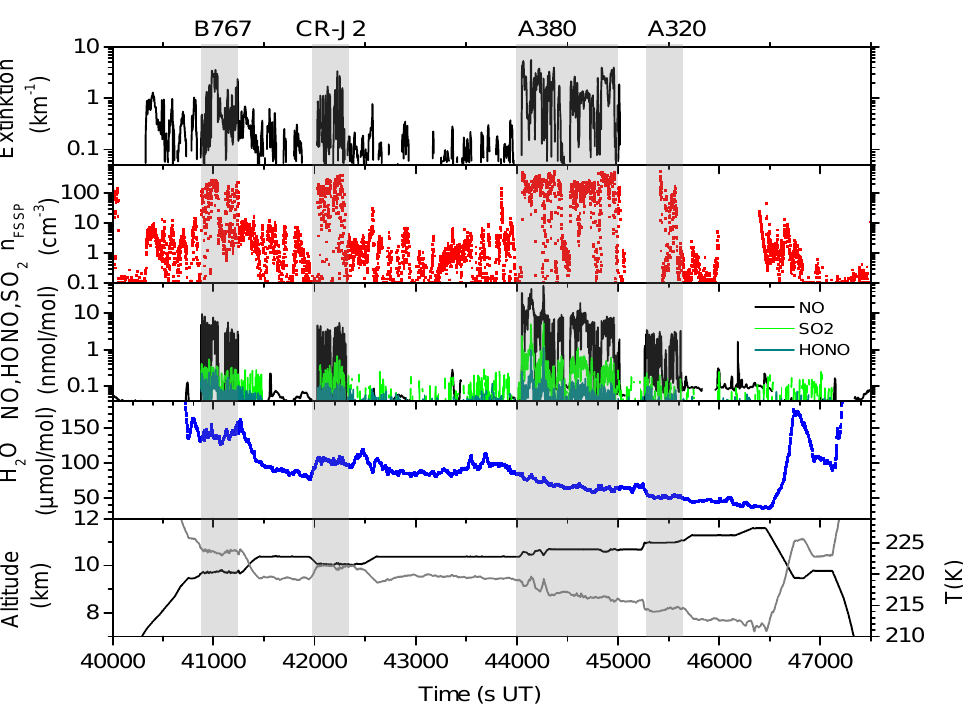
Fig. 6. Contrail flight B on 19 November 2008 above Germany from Hamburg to Oberpfaffenhofen. The flight altitude, temperature, and the H 2 O, NO, SO 2 and HONO mixing ratios as well as the particle number density detected with the FSSP and the extinction for particles larger than 3µm are shown. Sequences of contrail encounters of a B767, a CRJ-2, an A380 and an A320 are marked in gray. Gaps in the NO, SO 2 and HONO mixing ratios are related to instrument calibrations. The PN stopped working at 45050 s UT and there is a gap in the FSSP data between 45050 s and 45410 s UT.